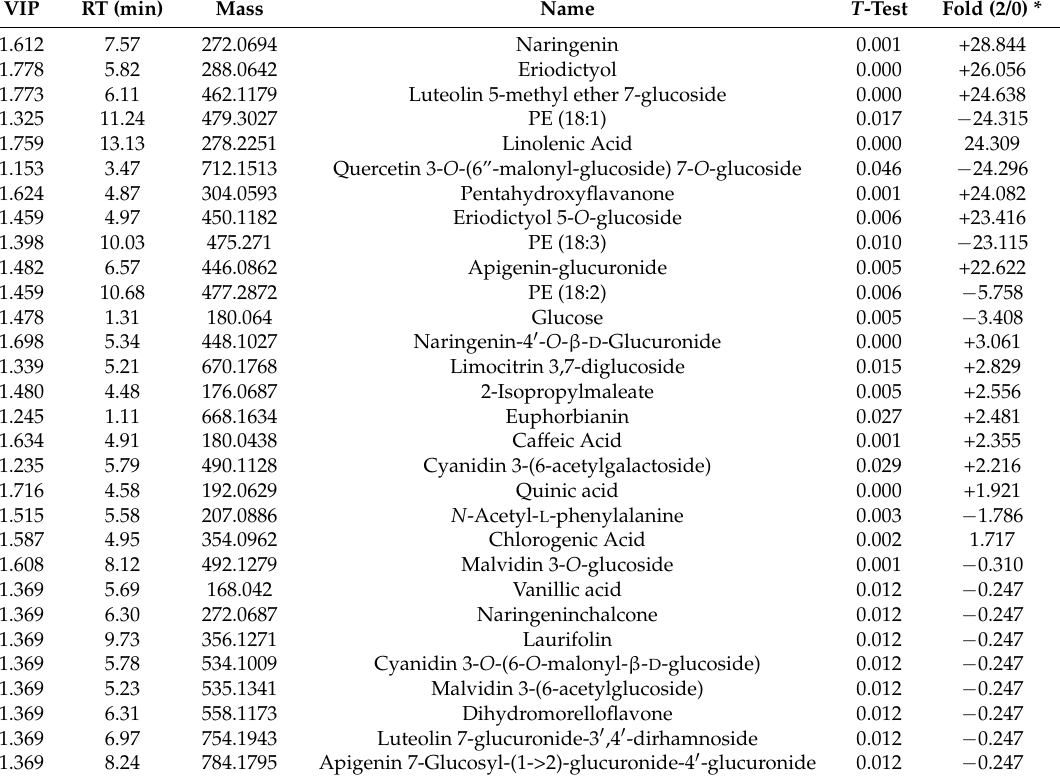
Table 2. The main identification obtained between 0 day and 2 days in ESI − ( p <